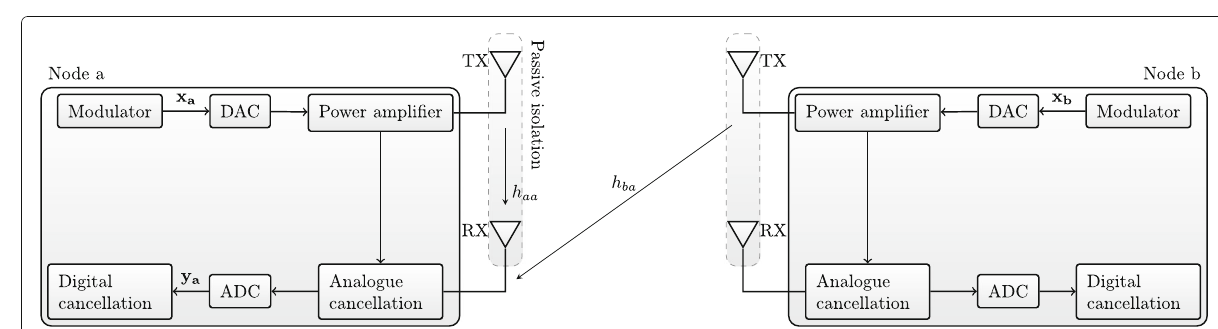
Fig. 1 Illustration of full-duplex communication between two transceivers, each with a single transmit and a single receive antenna. ADC analog-to-digital converter, DAC digital-to-analog converter, TX transmit, RX